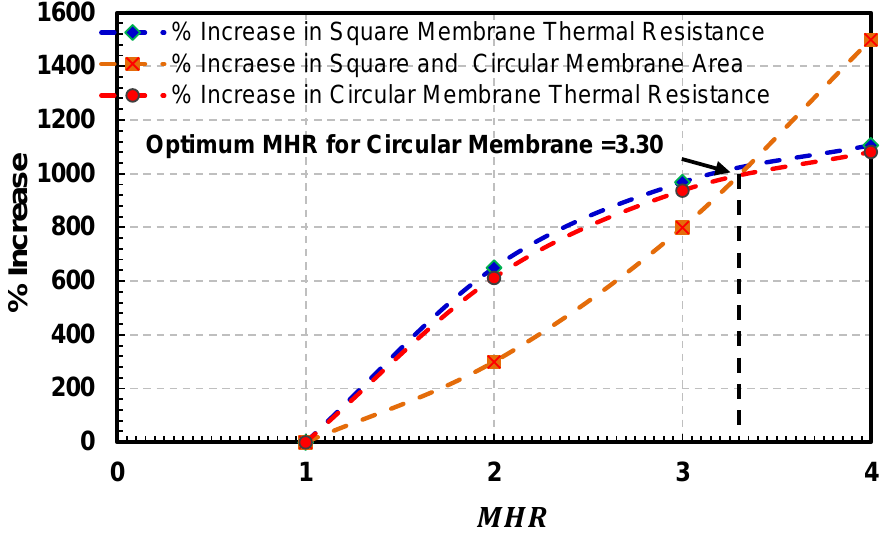
Figure 12. Plot showing the percentage increase in both square and circular membrane areas and increase in their thermal resistance with the increasing MHR. For circular membranes, the optimum MHR = 3.30, compared to the optimum MHR = 3.35 for squaremembranes.